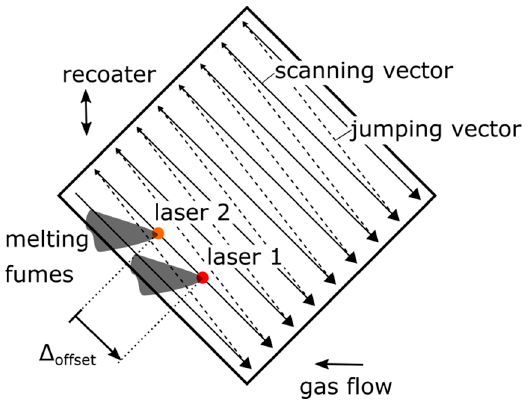
Figure 2. Dual-laser scanning strategy for specimen manufacturing.